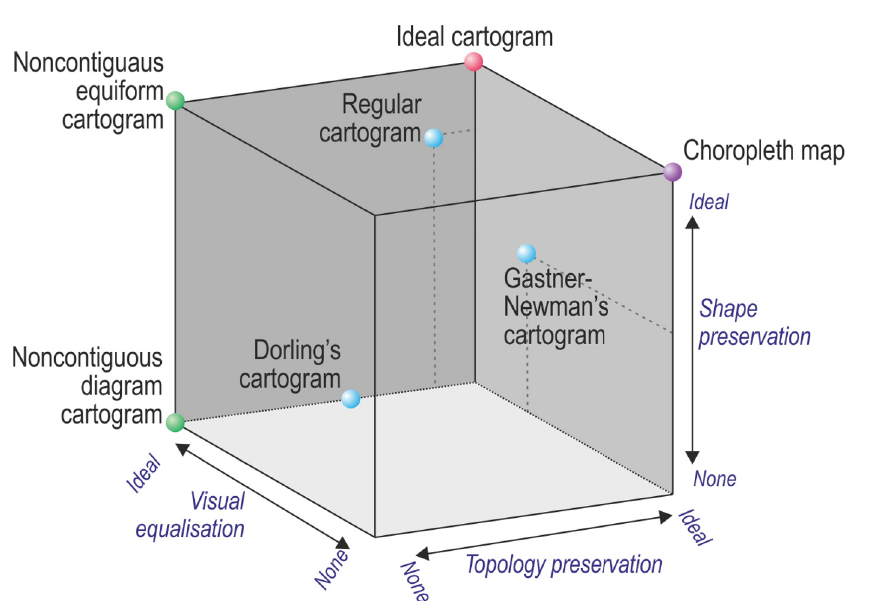
Fig. 7. Cartogram Cube ‒ cube of preserving the characteristics of area cartograms classes. Contiguous cartograms are marked in blue, green – noncontiguous cartograms, violet – a traditional map, and red – perfect area cartogram. Map location in cube based on R.E. Roth et al. 2010 (R.E. Roth et al.